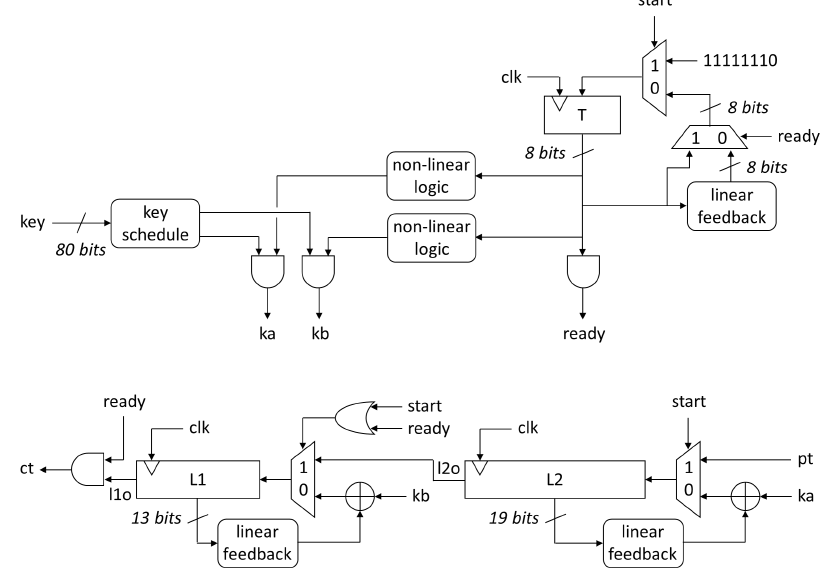
Figure 4: Hardware architecture of the KTANTAN32